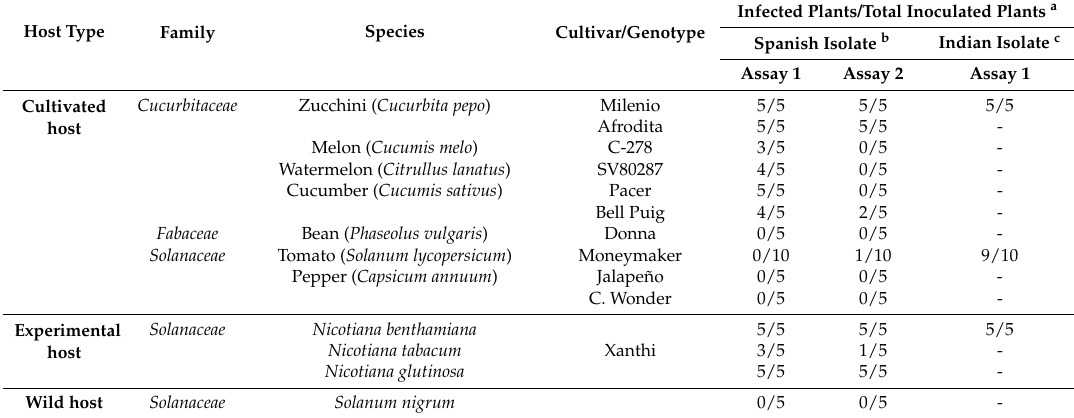
Table 3. Inoculation of the Spanish isolate [ES-Alm-661-Sq-13] of ToLCNDV in plants of a range of cultivated, wild and experimental host species by means of Agrobacterium tumefaciens -mediated inoculation; the Indian isolate ToLCNDV-[IN-ND-Svr-92] (GenBank Accession Numbers U15015 and U15017 for DNA-A and DNA-B, respectively) was included as a